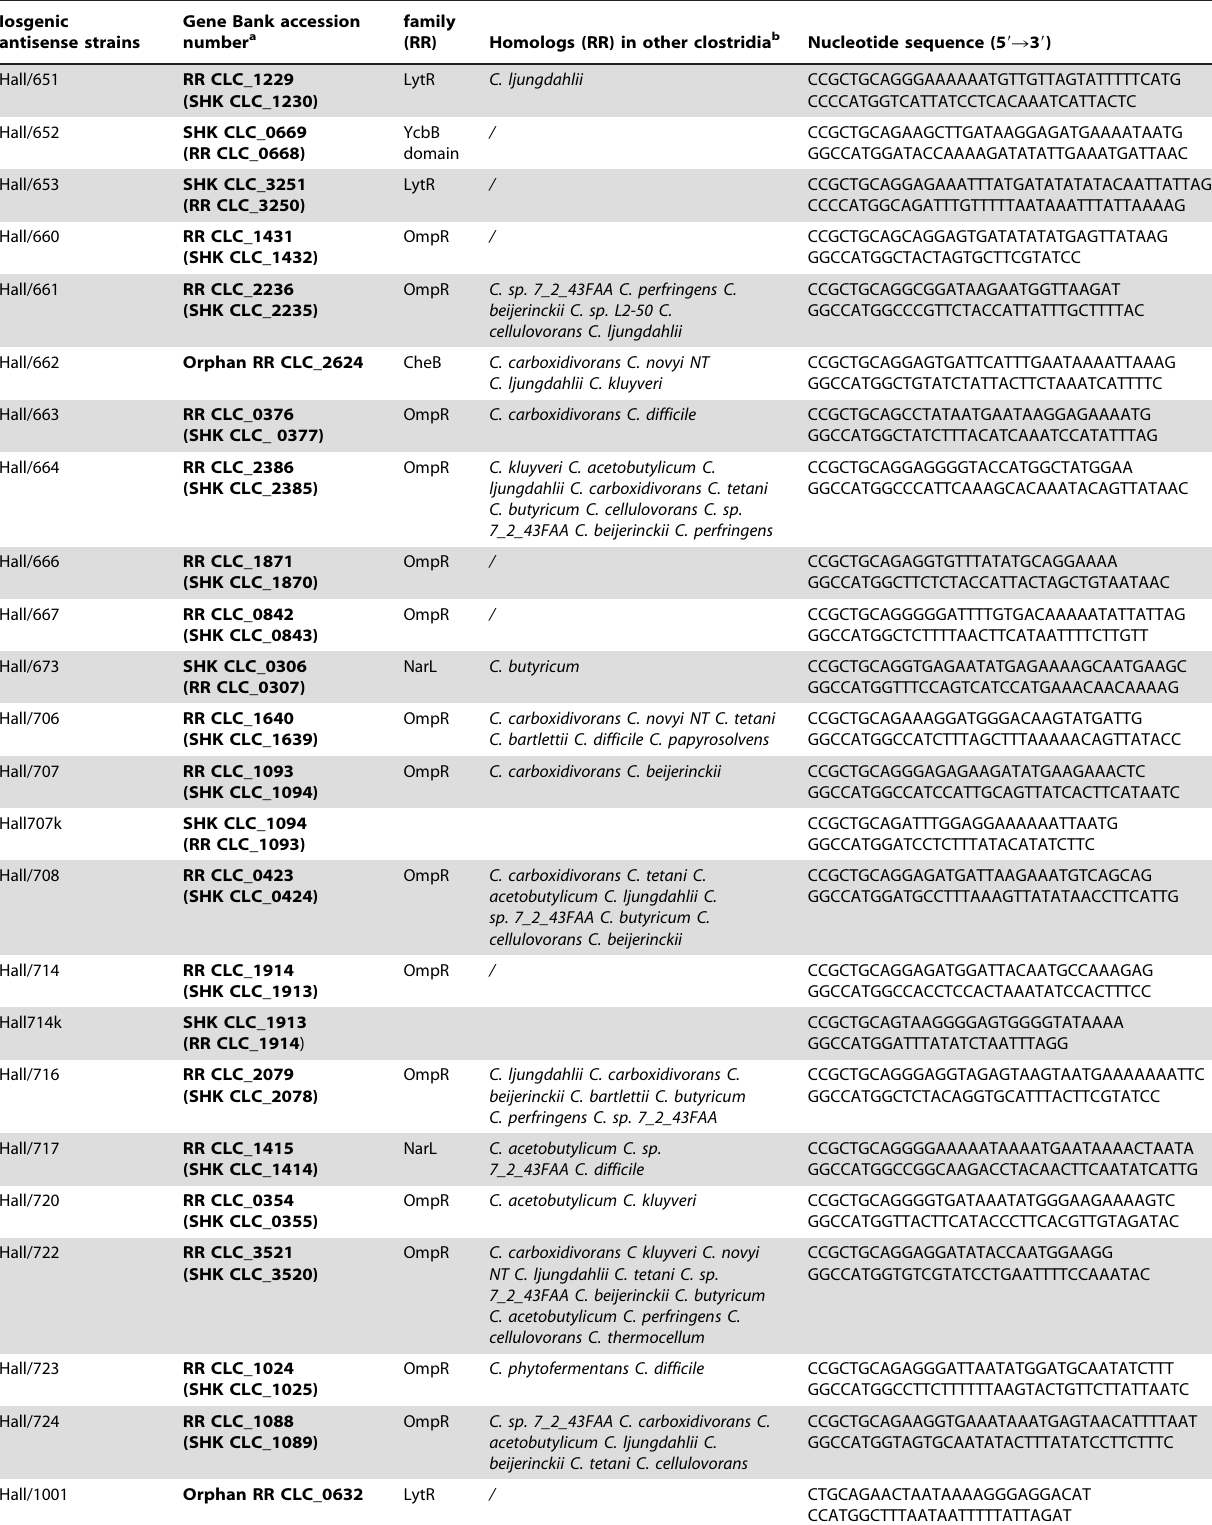
Table 2. Two-component system and orphan response regulator genes in C. botulinum strain Hall, homology with regulatory genes in other bacterial species, Hall isogenic antisense strains, and primers used for the construction of recombinant plasmids generating antisense